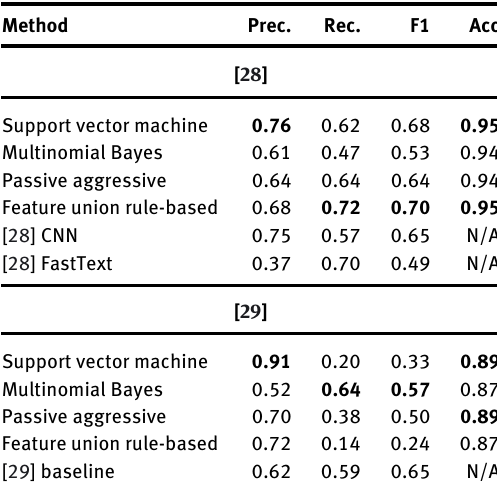
Table 4: Classification